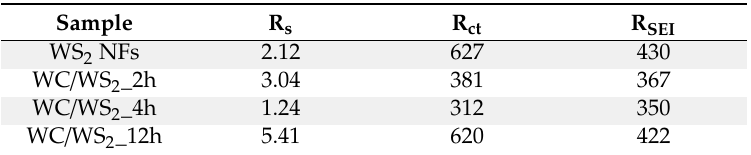
impedance spectroscopic (EIS) measurement. 256